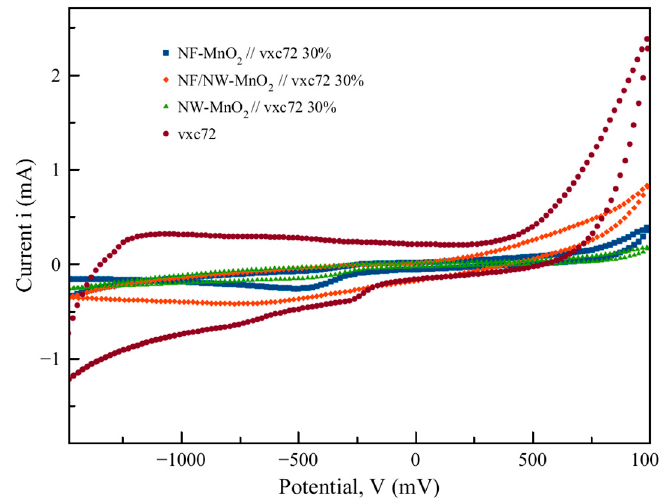
Figure 3. Cyclic voltammetry of pure carbon Vulcan XC 72, Nanoflower-like MnO 2 , nanoflower– Figure3. CyclicvoltammetryofpurecarbonVulcanXC72, Nanoflower-likeMnO 2 , nanoflower–nanowire- nanowire-like MnO 2 , nanowire-like MnO 2 in O 2 saturated with 0.1-M KOH at a 50-mV/s scan rate. like MnO 2 , nanowire-like MnO 2 in O 2 saturated with 0.1-M KOH at a 50-mV / s scan